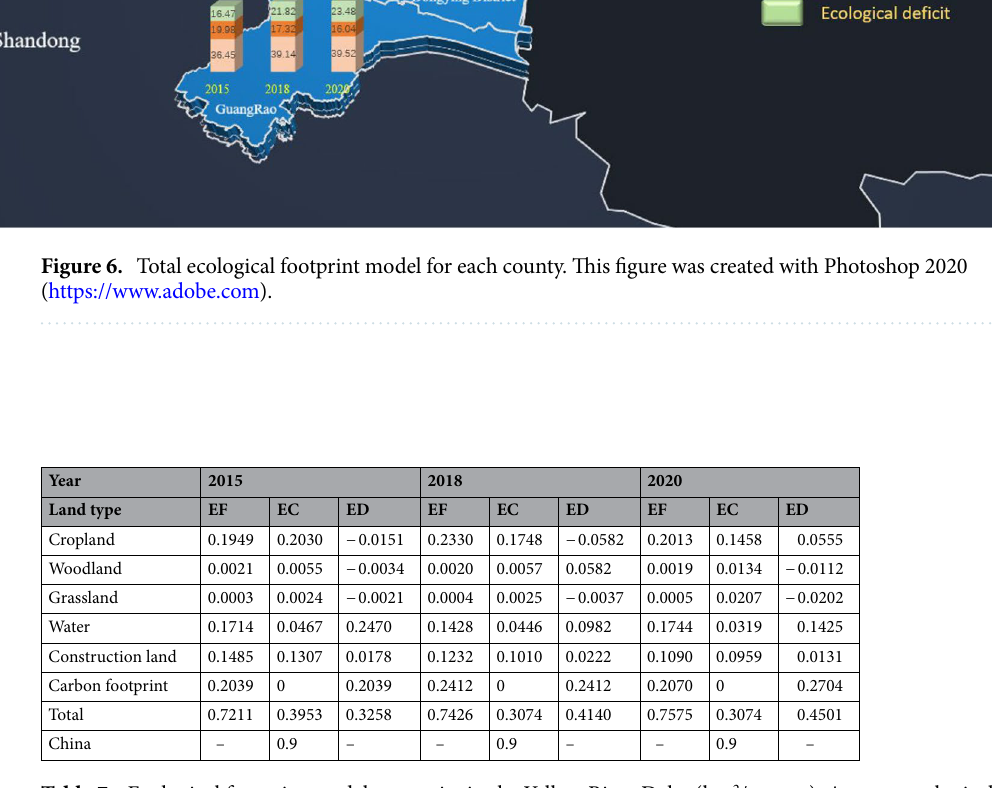
Table 7. Ecological footprint model per capita in the Yellow River Delta (hm 2 /person). Average ecological carrying capacity per capita in China from data published by the Global Footprint Network (https:// www. footp rintn etwork.